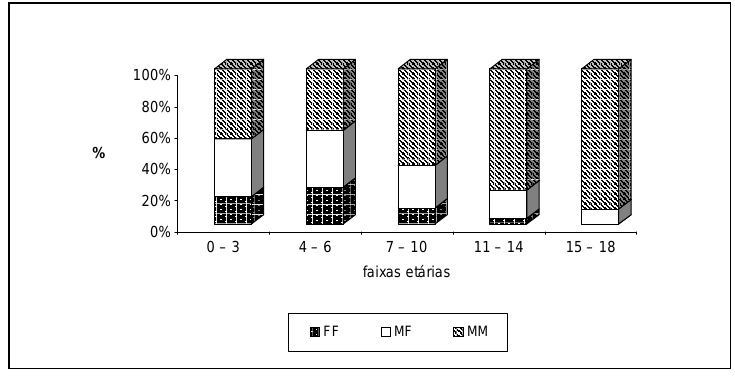
Figura 2 . Relação entre as faixas etárias e composição dos